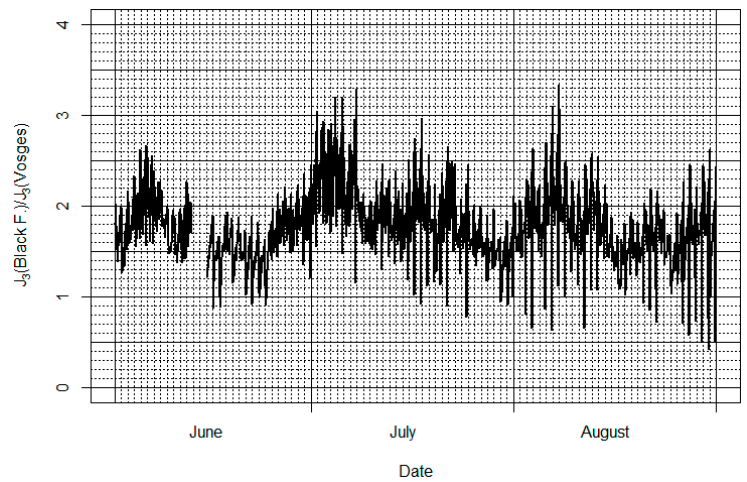
Figure 6. Forest effect on newly formed aerosol particles from natural sources [40] during the summer. Ratio of particle formation rates in Black Forest and the Vosges area.